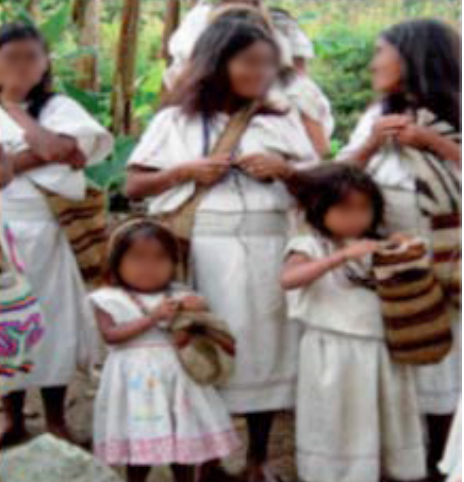
Figure 4. Grandmother teaches knitting fique. Photo by Dwrya Izquierdo (2015).